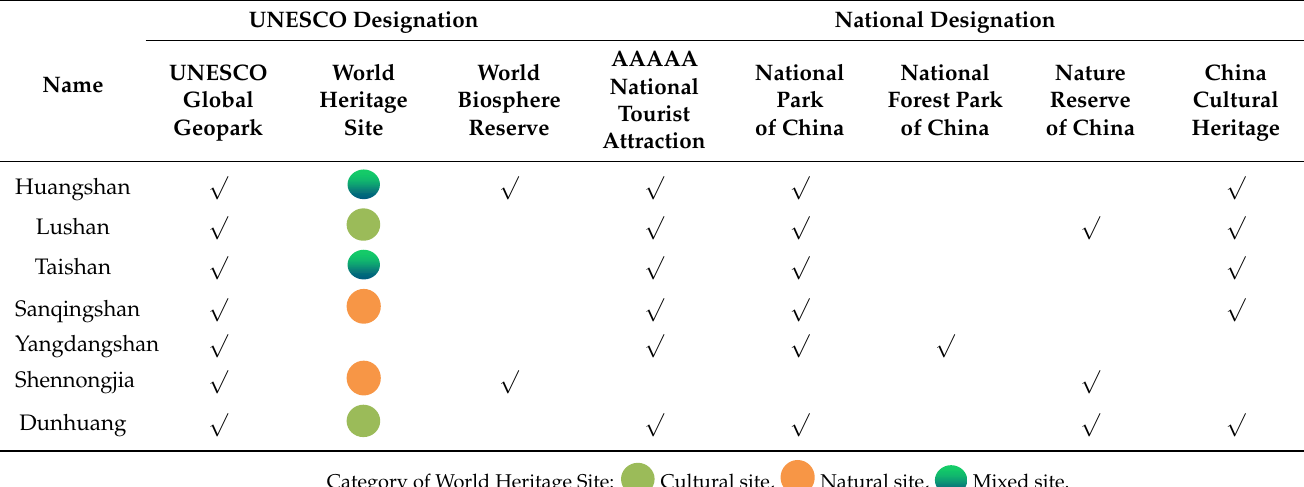
Table 3. Other designations in addition to UGGps (modified from [105]).